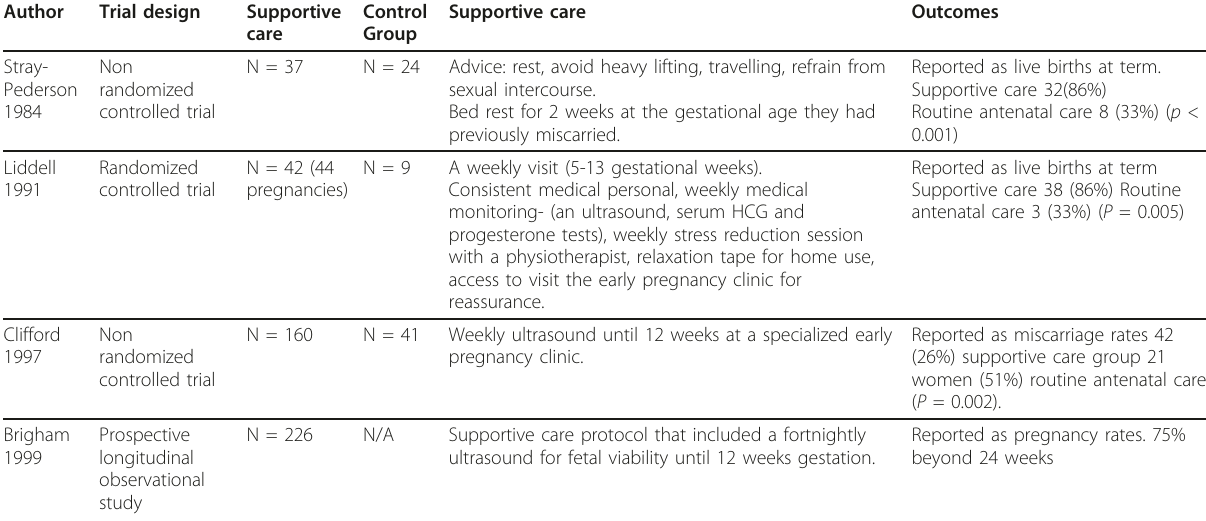
Table 1 Supportive Care use in Recurrent Miscarriage Studies 1984 -